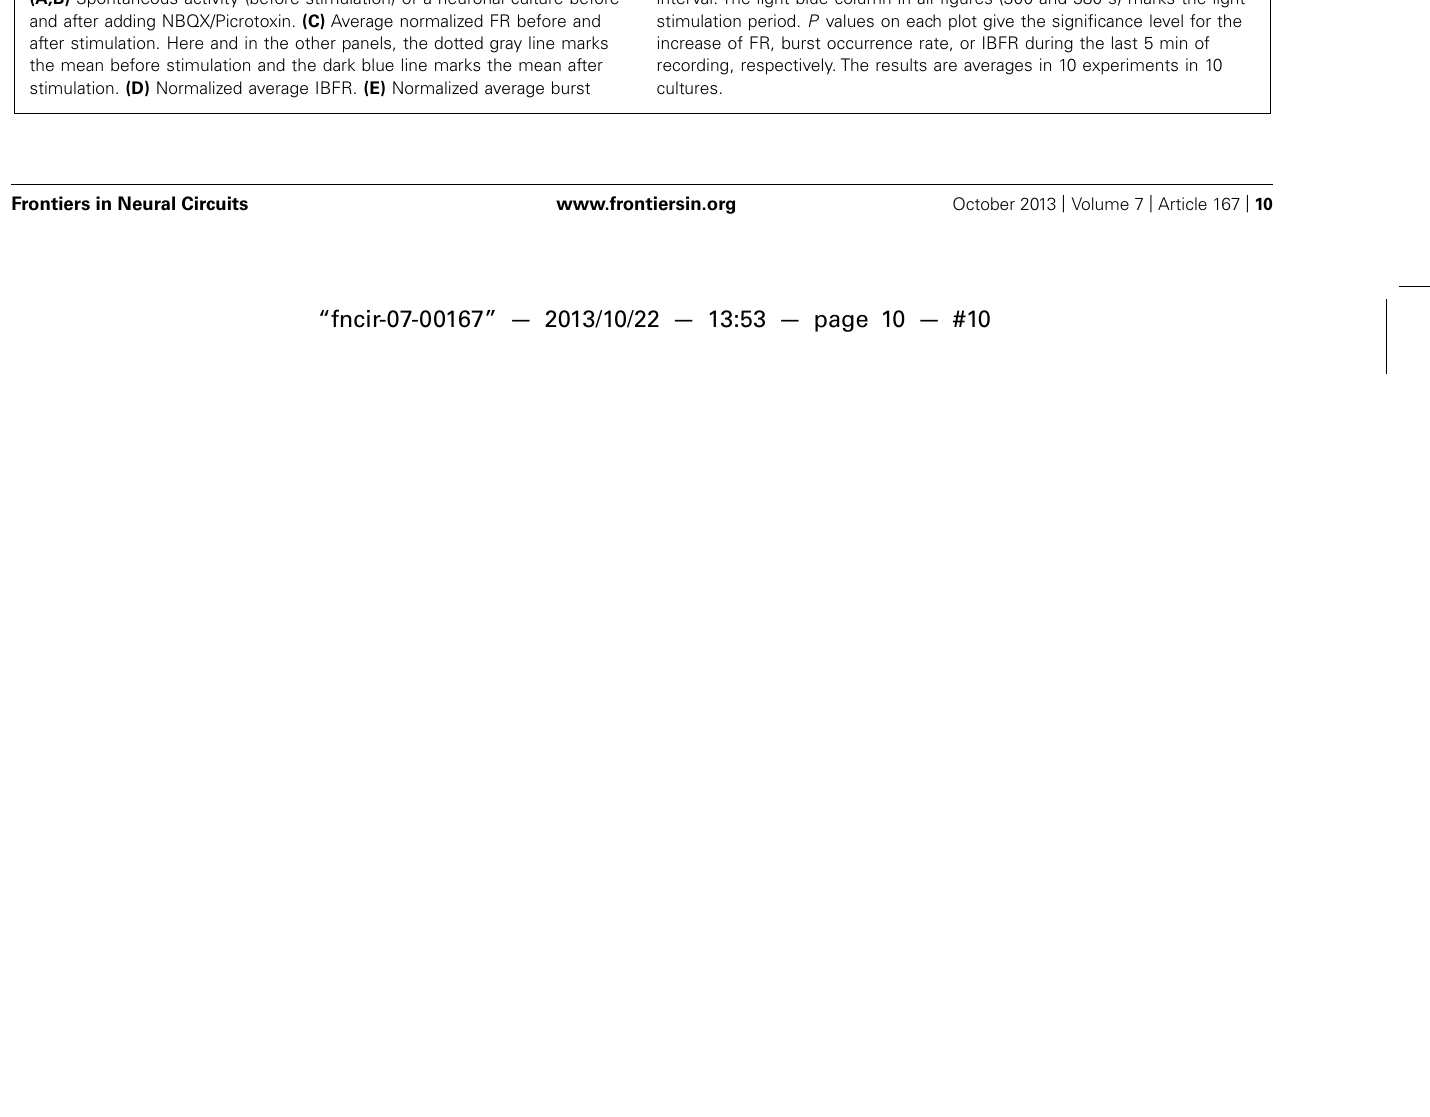
FIGURE 7 | Network plasticity in the presence of NBQX/Picrotoxin. (A,B) Spontaneous activity (before stimulation) of a neuronal culture before and after adding NBQX/Picrotoxin. (C) Average normalized FR before and after stimulation. Here and in the other panels, the dotted gray line marks the mean before stimulation and the dark blue line marks the mean after stimulation. (D) Normalized average IBFR. (E) Normalized average burst